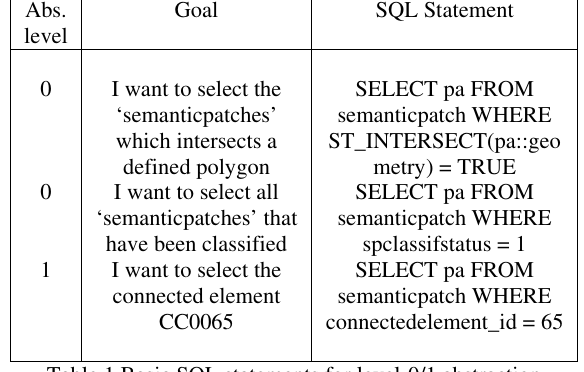
Table 1 Basic SQL statements for level-0/1 abstraction